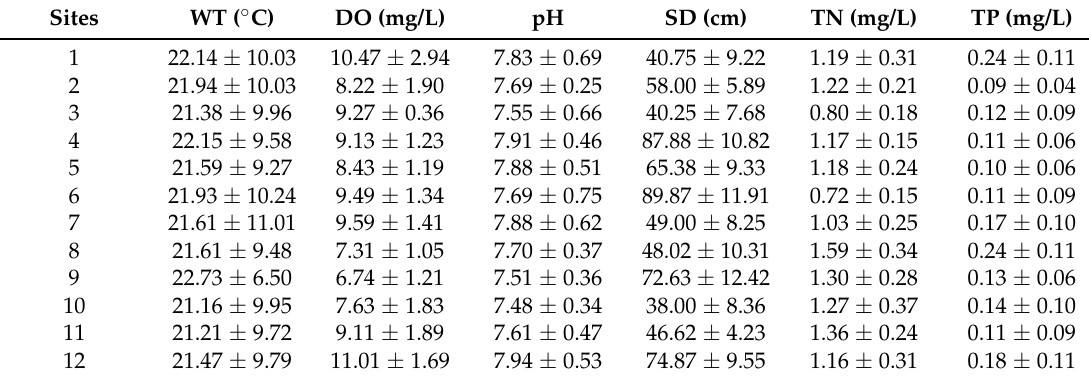
Table 1. Environmental factors for each sample site, values are expressed as mean ± standard deviation. WT: water temperature; DO: dissolved oxygen; SD: Water transparency; TN: total nitrogen; TP: total